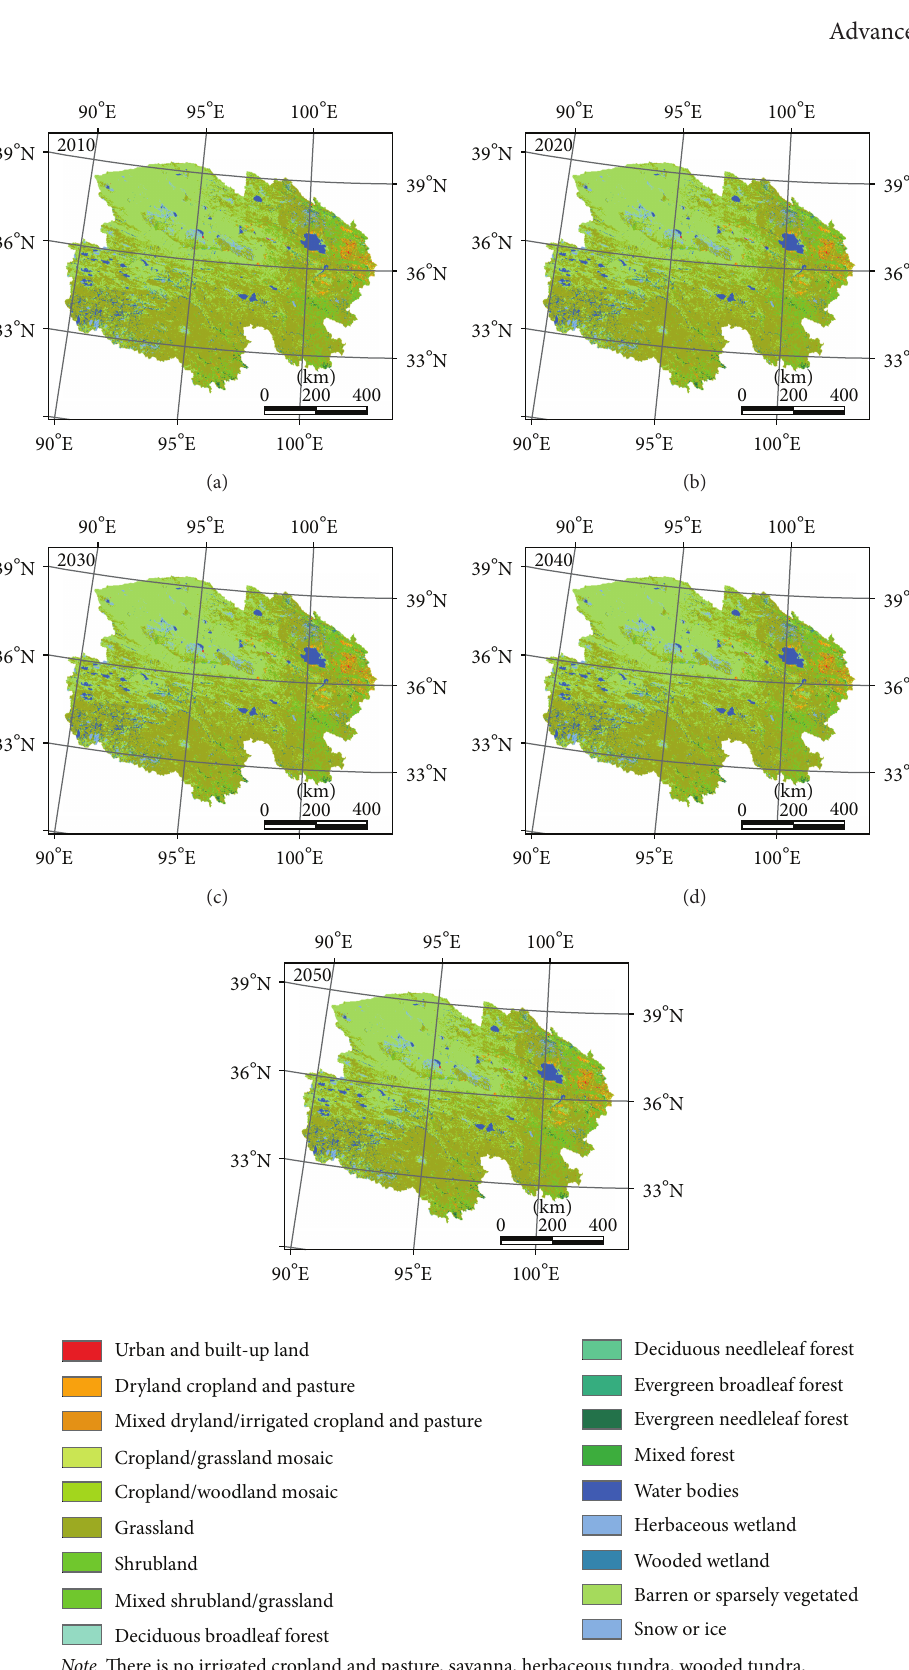
Figure 3: Simulated LUCC in Qinghai Province of China,